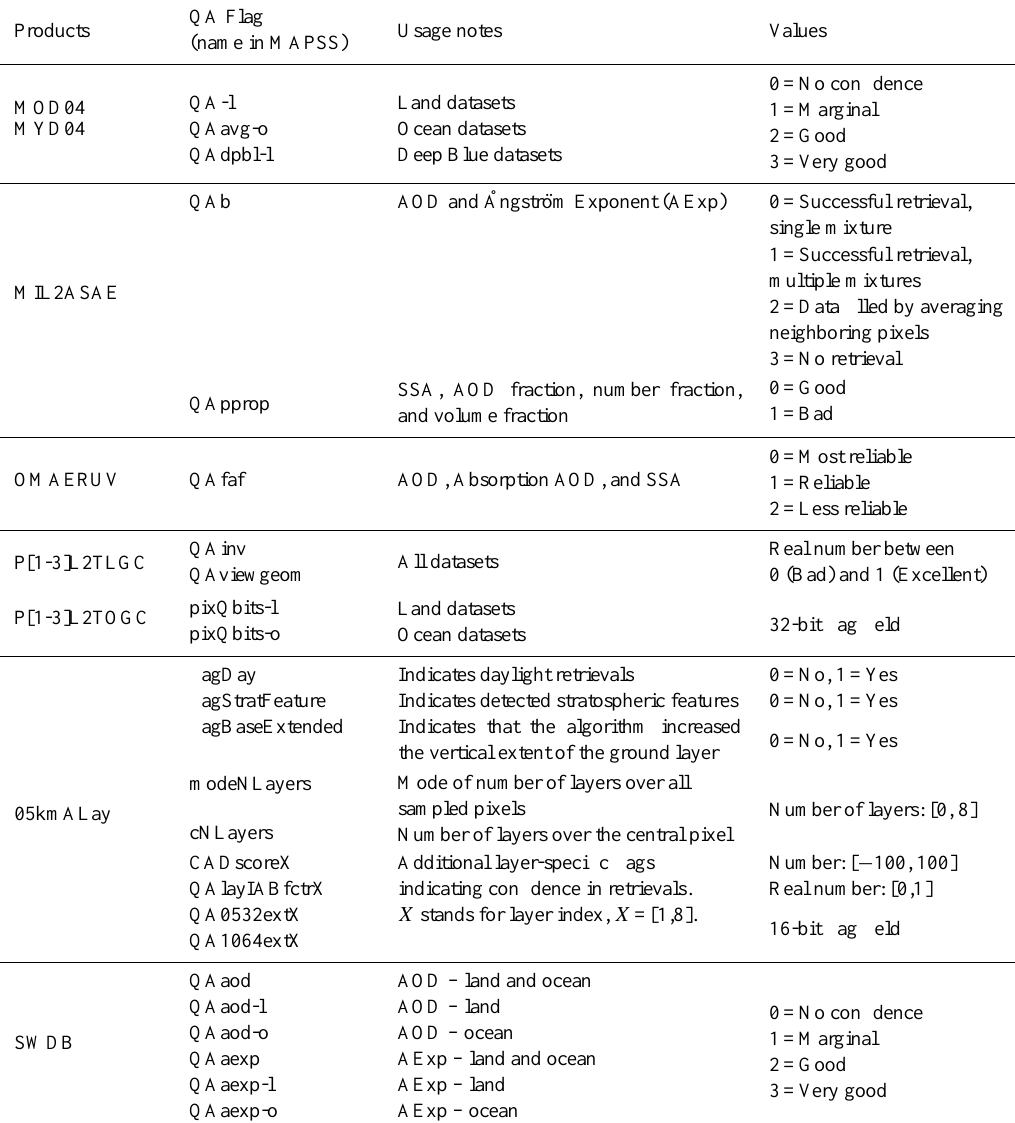
Table 2. Summary of the quality assurance/quality control (QA) flags and their values for the aerosol products supported in MAPSS. Note that “Land” and “Ocean” are used to indicate aerosol products retrieved over Land and Ocean,